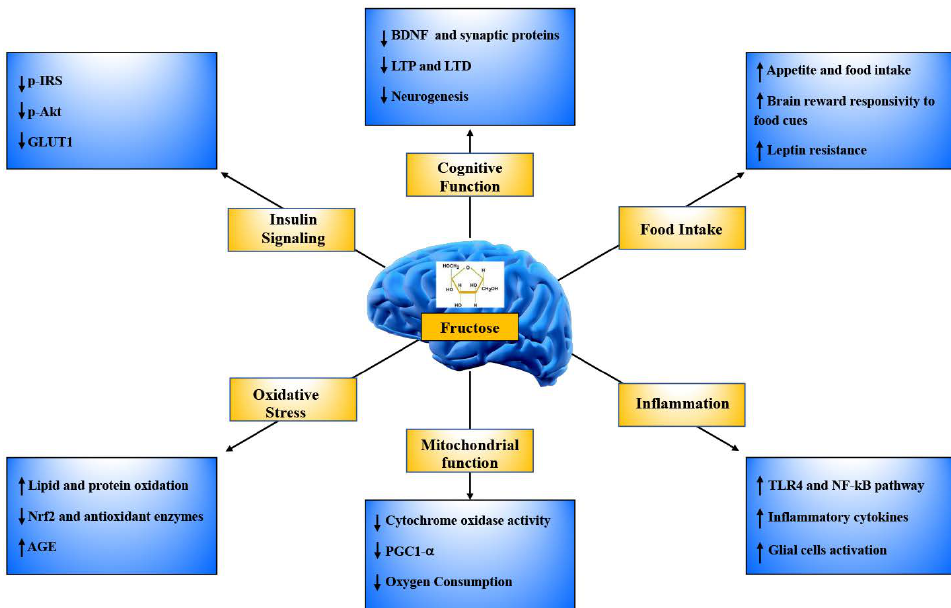
Figure 2. Major brain changes following fructose dietary introduction. The boxes indicate proteins and mechanisms modulated by fructose treatment in the brain in the context of the regulation of food intake, neuroinflammation, mitochondrial function, oxidative stress, insulin signaling and cognitive function. Up arrows indicate parameters stimulated and down arrows indicate parameters reduced by fructose intake. p-IRS = phosphorylated insulin receptor and insulin receptor substrate 1; p-Akt = serine/threonine protein kinase B; GLUT1 = glucose transporter 1; NRF2 = nuclear factor 2; AGE = advanced glycation end products; BDNF = brain derived neurotrophic factor; LTP = long-term potentiation; LTD = long-term depression; PGC1- α = peroxisome proliferator-activated receptor gamma coactivator-1 alpha; TLR4 = toll-like receptor 4; NF-kB = nuclear factor kappa-light-chain- enhancer of activated B